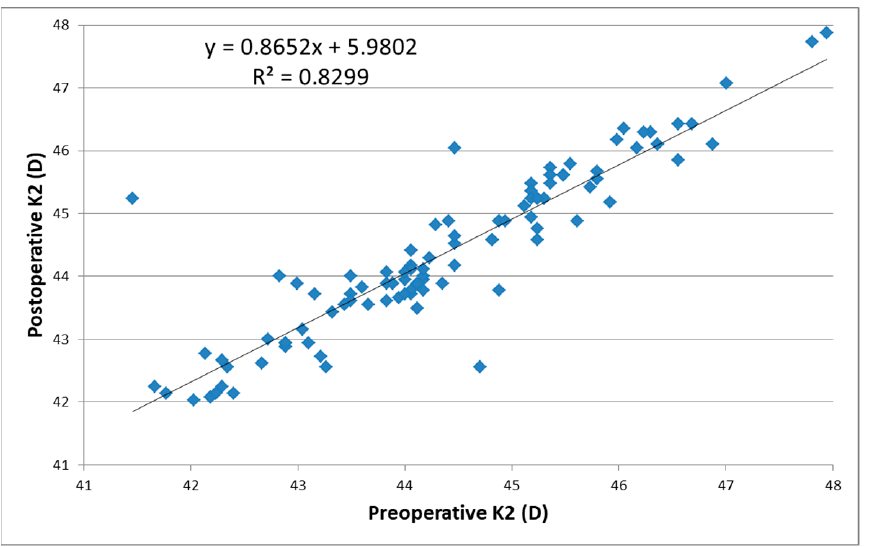
Figure 5. Correlation between the postoperative and preoperative values of parameter K2 for astigmatism (steepest point—steepest K).